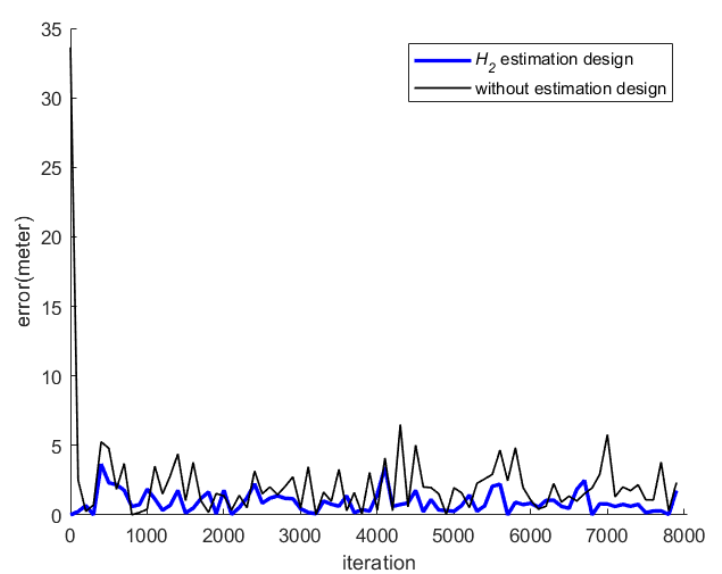
Figure 17. Histories of positioning errors of the proposed estimation design with respect to the po- sitioning scheme without using any estimation design (real test).